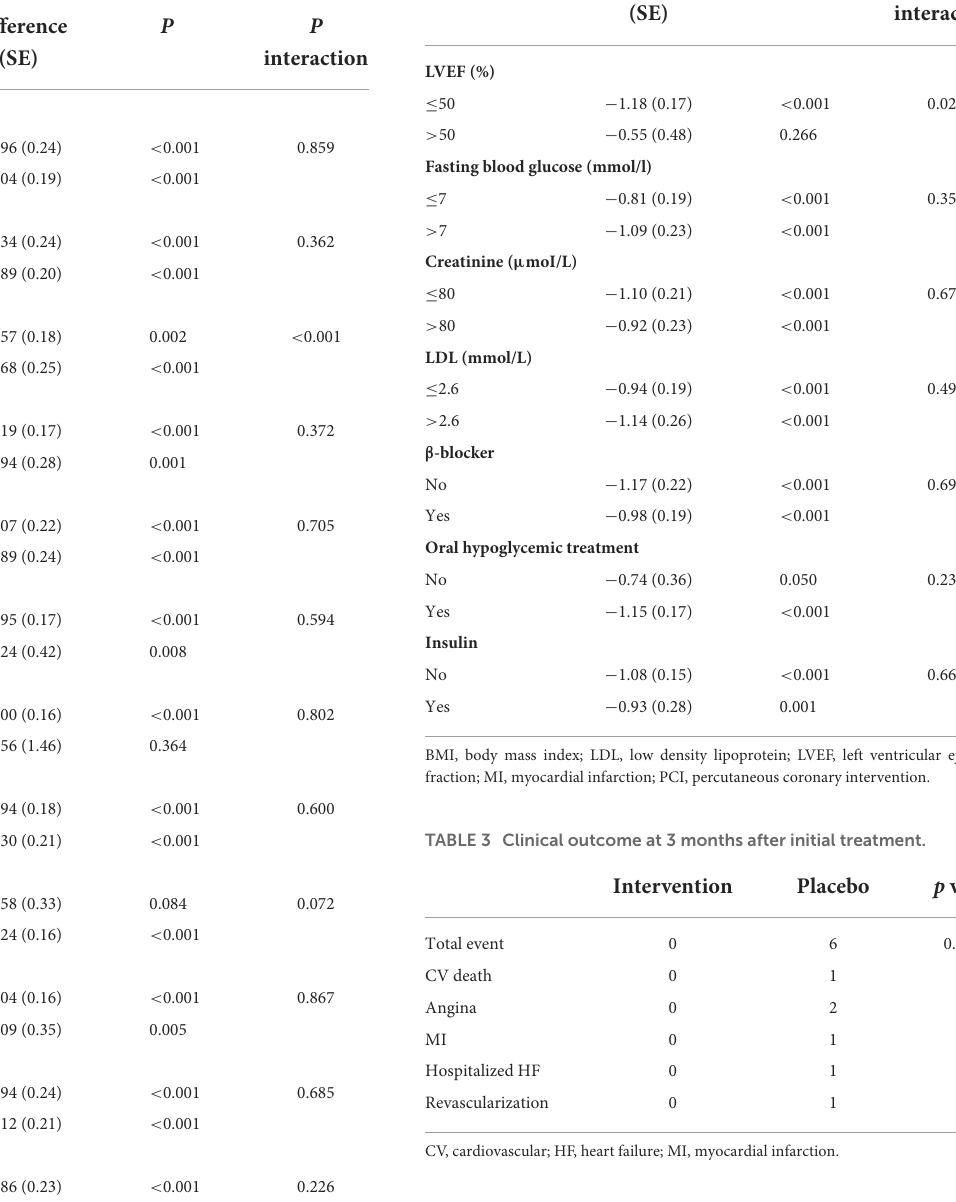
TABLE 2 Subgroup analyses of the difference between the intervention and control groups in the mean change of hemoglobin A1C (HbA1C) from baseline to 3 months.